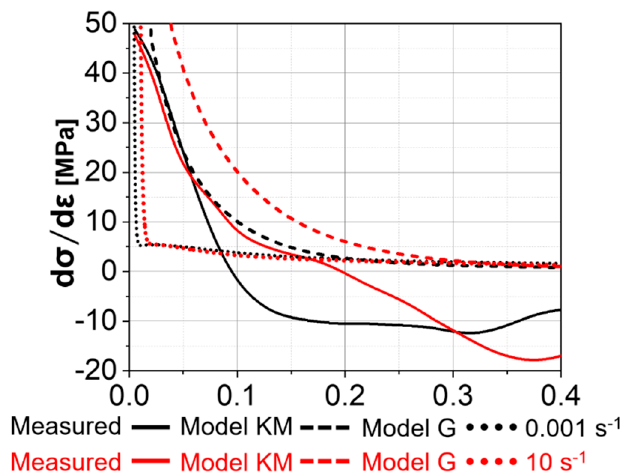
Figure 7. Derivative of the total stress with respect to the strain for the Ti-17 deformed at 970 °C with the strain rates of 0.001 s − 1 and 10 s − 1 and for ”Model KM” and “Model